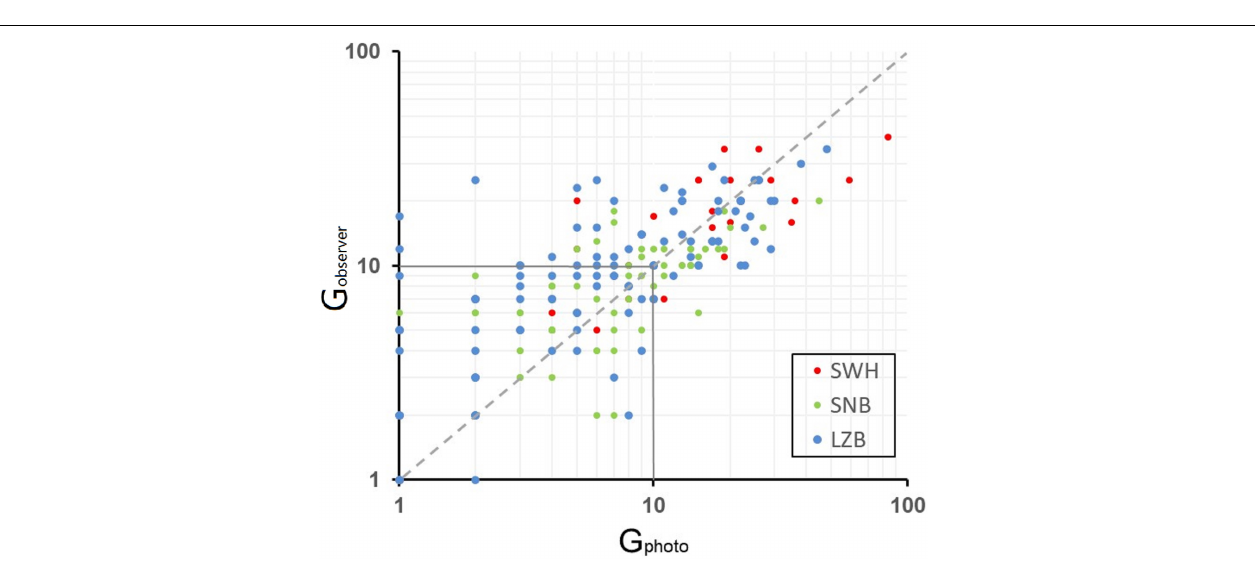
FIGURE 4 | R observer / photo of humpback dolphin group size on a log-log scale: observer-based counts ( G observer ) against photo-identification estimates ( G photo ) . The grey dash line is the 1:1